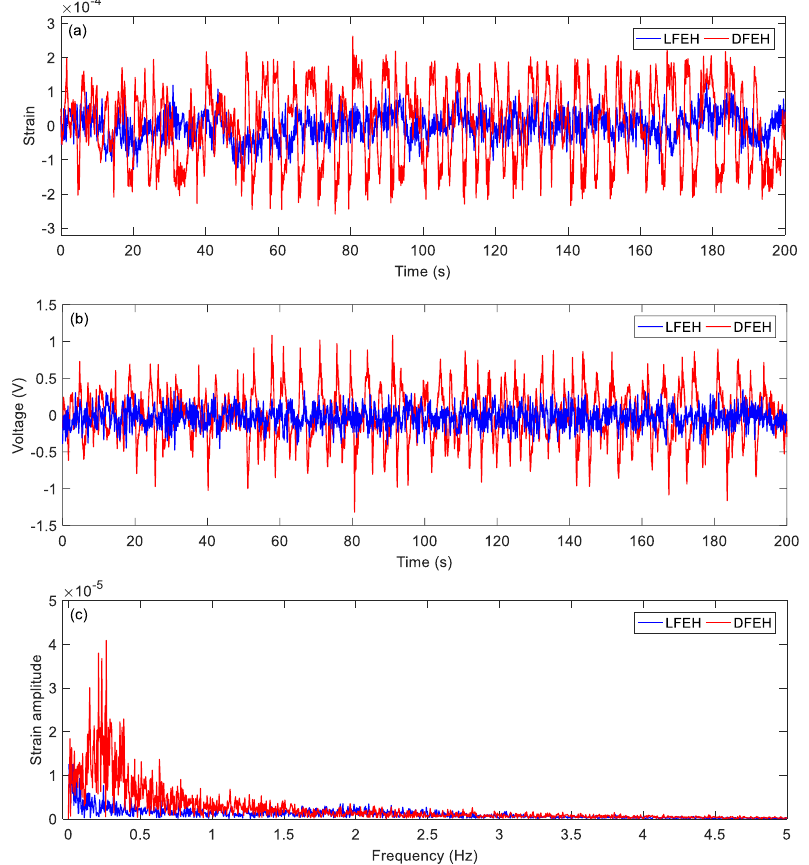
Figure 14. ( a ) Time histories of strain response, ( b ) time histories of voltage response, ( c ) spectrum of dynamic strain response ( v = 4.5 m/s).